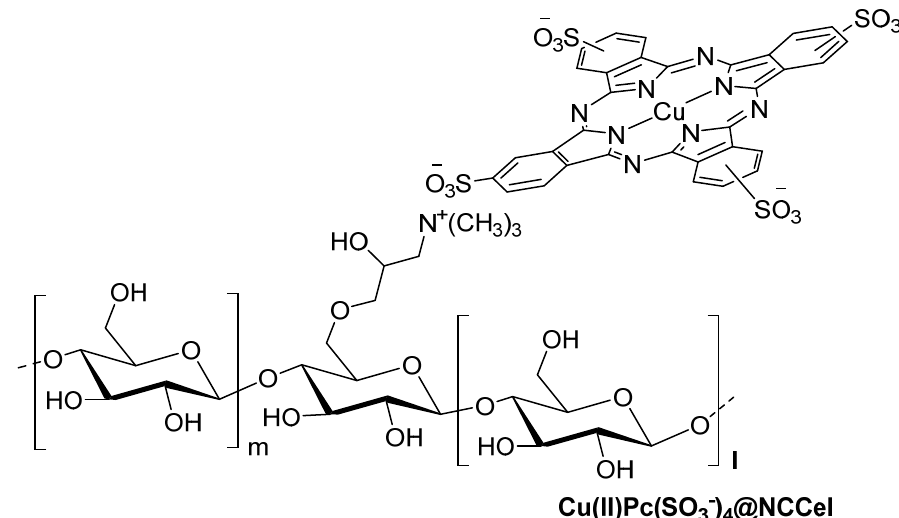
Figure 26. Graphical representation of the hybrid material Cu(II)Pc(SO 3- ) 4 @NCCel prepared trough electrostatic interaction of copper(II) tetrasulfonate phthalocyanine (tetrasodium salt) CuPc(SO 3 Na) 4 on the quaternary amine functionalized nanocrystalline cellulose (NCC). (adapted from [75]).